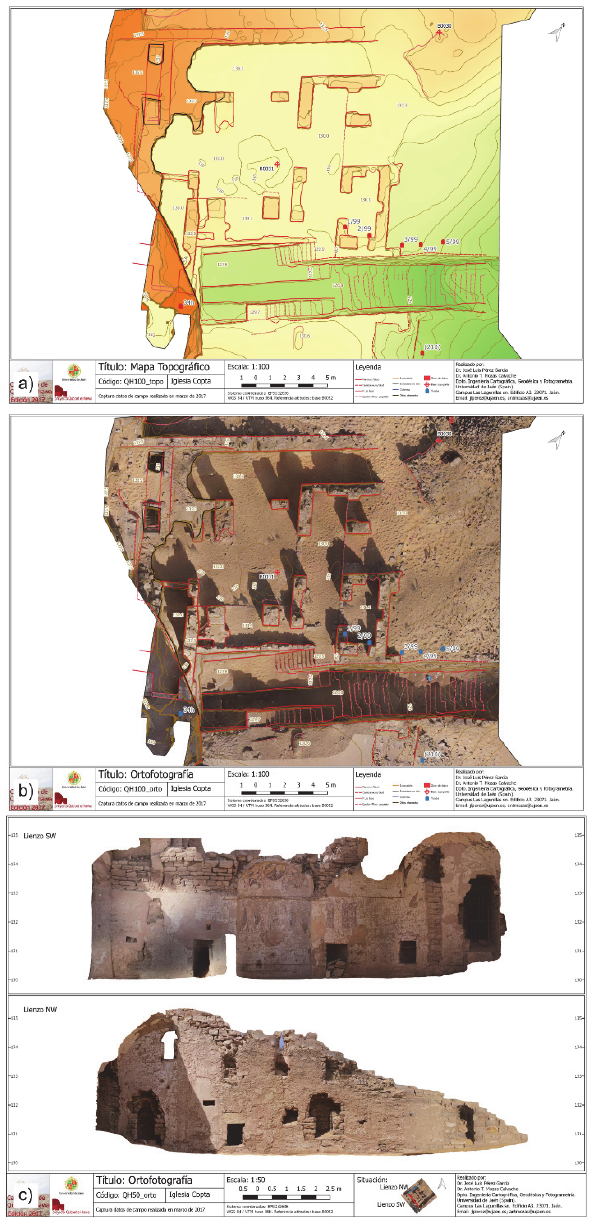
Figure 8. Maps of the Qubbet el-Hawa Coptic Church at scale 1:100: a) Topographic map; b) ground orthoimage map; c) SW and NW walls orthoimage map.